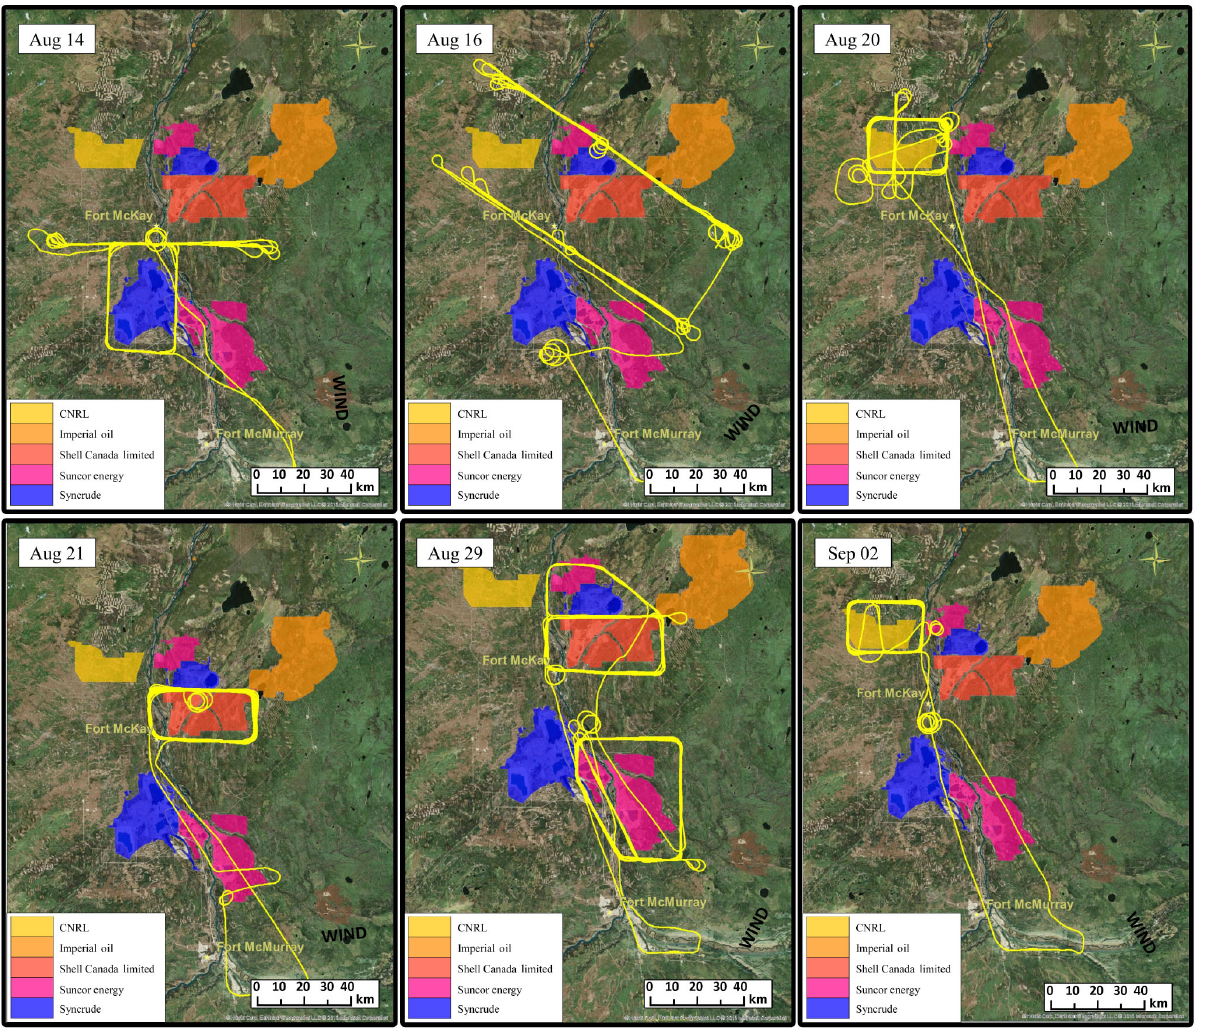
Figure 1. Flight tracks from flights capturing emissions from SML (14 and 16 August), SUN (16 and 29 August), CNRL (20 August, 2 September), SAJ (21 August, 6 September not shown) and SAU (29 August, 6 September not shown). SML and SAU are shown in blue, SUN in pink, CNRL in yellow and SAJ in dark